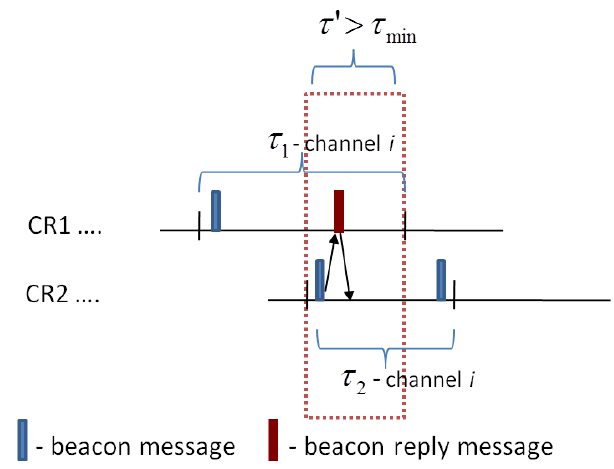
Figure 7. Rendezvous at channel i